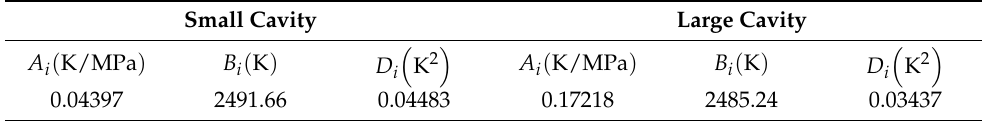
Table 1. Calculation parameters of the Langmuir constant of methane. Small Cavity Large